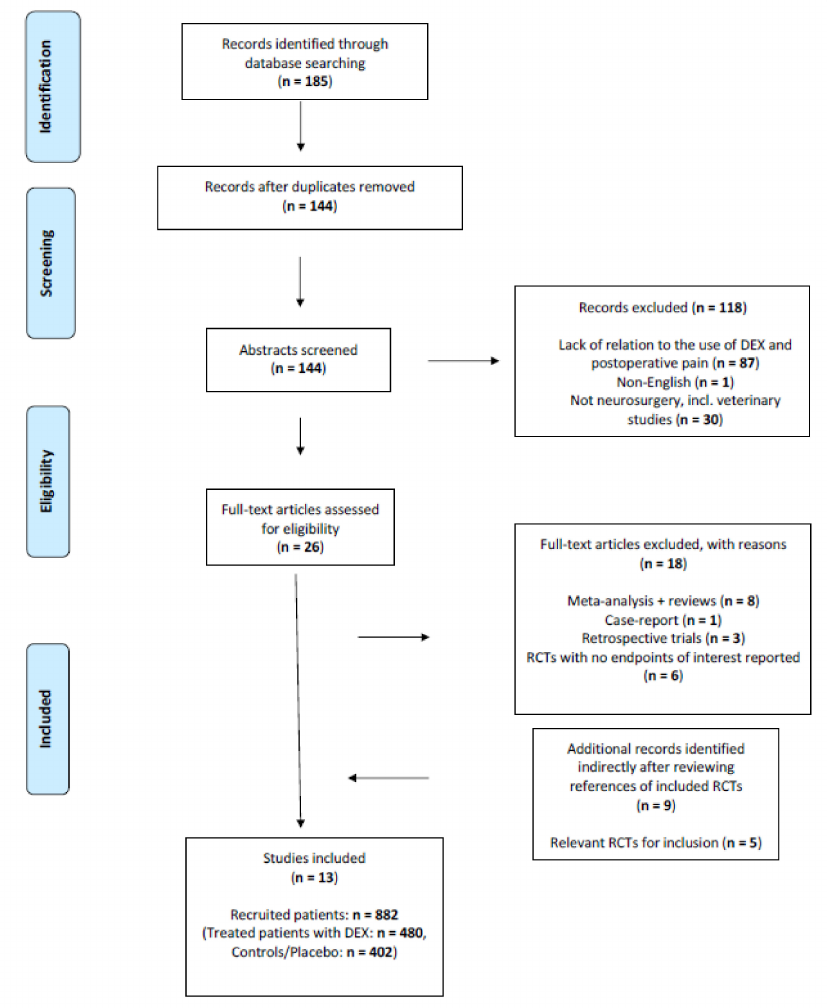
Figure 1. Flow diagram of study